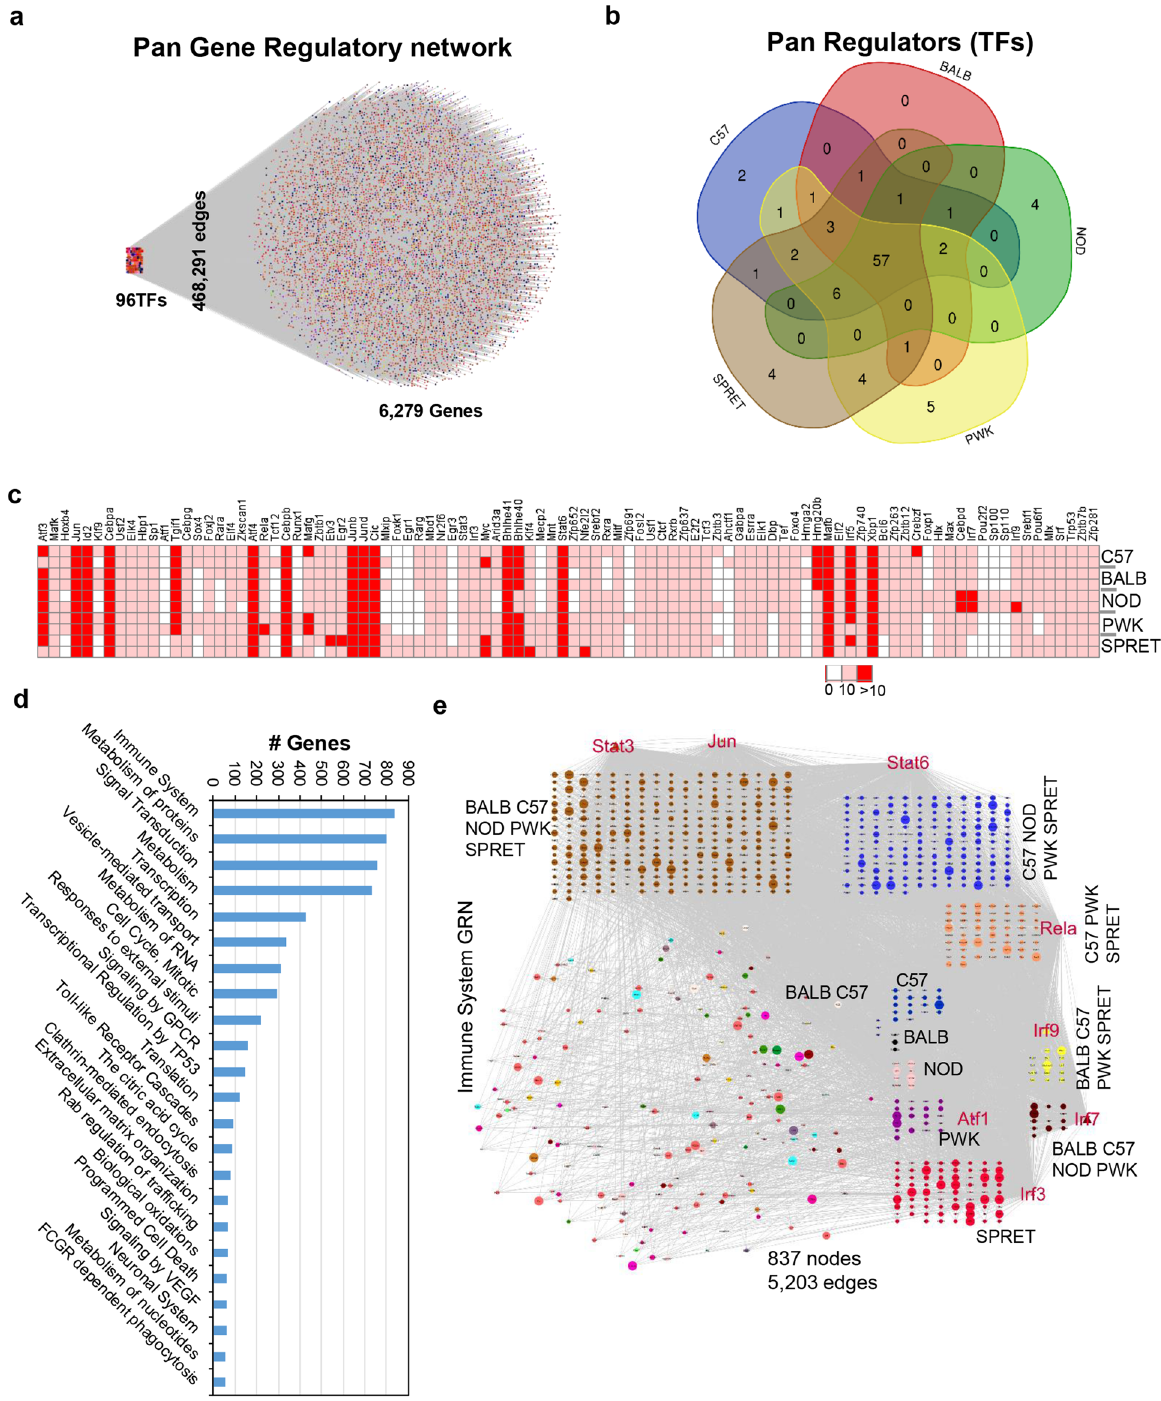
Figure 5. The five consequential GRNs modeled pan basal regulation atlas of unstimulated macrophage in the murine model. ( a ) The pan GRN with 6375 nodes (6279 genes and 96 TFs) and 468,291 edges (interactions) across five mice strains. ( b ) Venn diagram representing the expression of unique and shared 96 TFs in five strains of mice. 57 TFs are expressed in all strains. ( c ) Heatmap of 96 Transcription Factors (TFs) present in pan GRN expressed across five strains of mice. The clustered columns represent TF expression, whereas each row represents different mice strain using correlation distance and average linkage. (Red: TPM > 10, White: TPM < 10). ( d ) Gene and pathway ontology identification of pan GRNs nodes by ClueGO. Some of the significantly enriched ontology terms are immune system, protein metabolism, signal transduction, transport, cell cycle, GPCR signaling, and RNA Metabolism ( P ≤ 0.001) (Supplementary Figure S2). ( e ) Pan immune system GRN (5203 edges with 837 nodes). There are eight TFs (Stat3, Jun, Stat6, Rela, Irf9, Irf7, Irf3, and Atf1) involved in pan immune GRN. The bigger size of the node denotes Hub 50 genes from the co-expression network